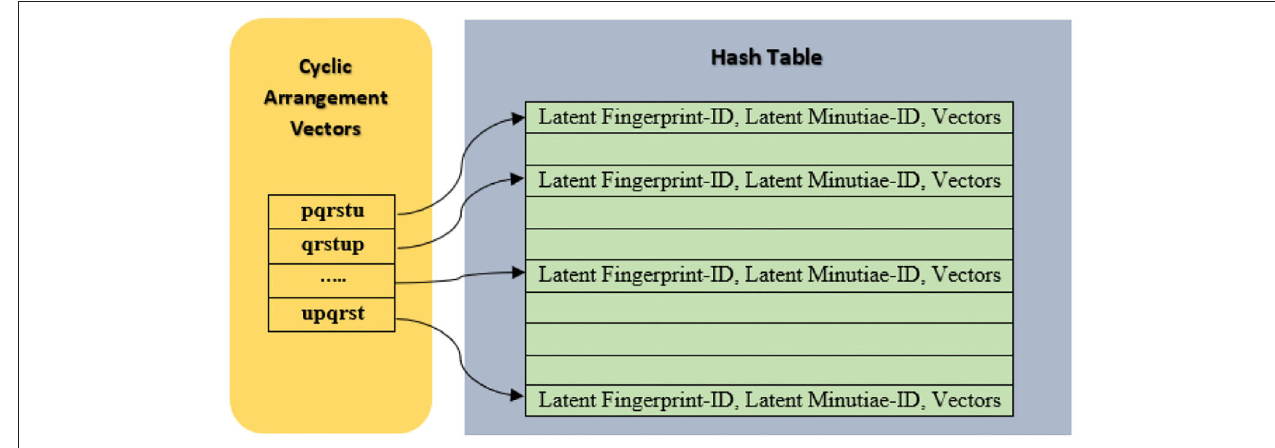
FIGURE 4 | Hash-Table construction for arrangement